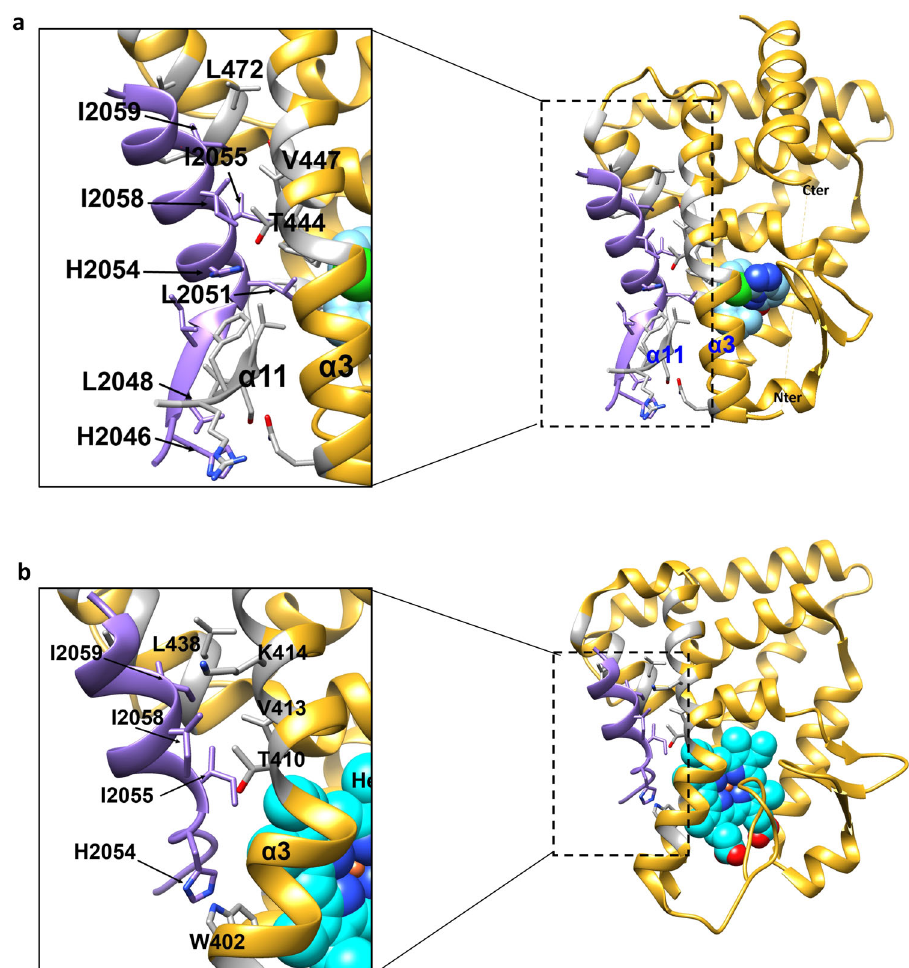
b Structure of heme/REV-ERB β LBD (yellow) bound to NCoR1 ID1 peptide (purple) (PDB: 6WMQ). Regions of the receptor interacting with NCoR are represented in gray. Heme is represented in space fi lled